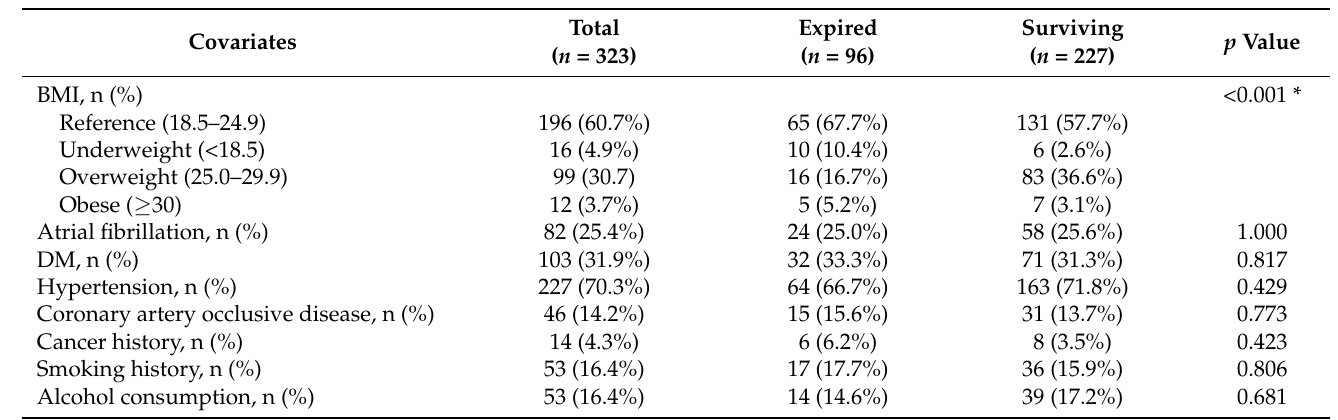
Figure 2 is a Kaplan–Meier survival function with a stratified analysis for the ALT level (<10 U/L and 10-40 U/L). The cumulative 79-month survival was 27.4% in patients with a significantly reduced ALT level versus 63.1% in patients with a normal level of ALT ( p < 0.001).